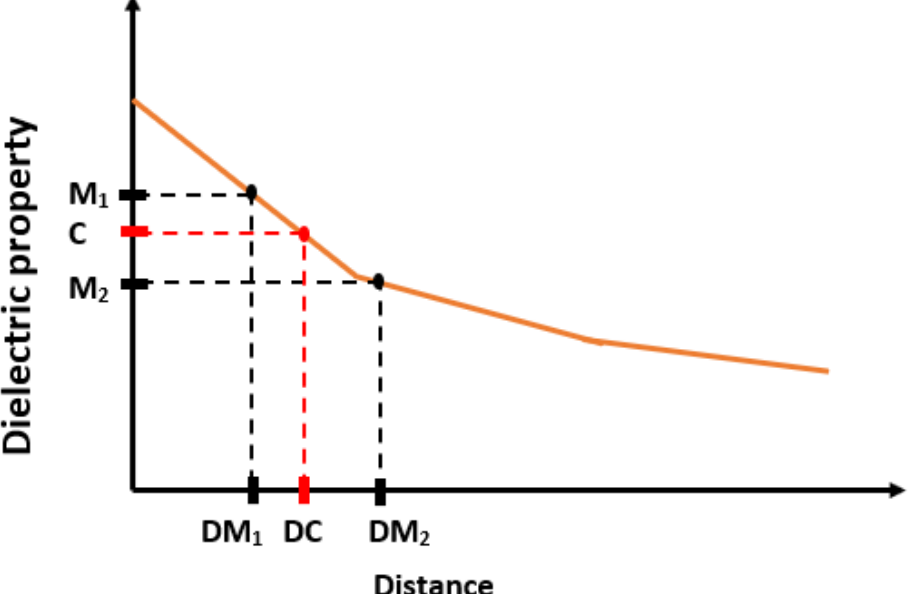
Figure 10. The distance (DC) was estimated for calculated dielectric property (C) based on percentage change using measured consecutive dielectric properties (M 1 and M 2 ) and their distances (DM 1 and DM 2